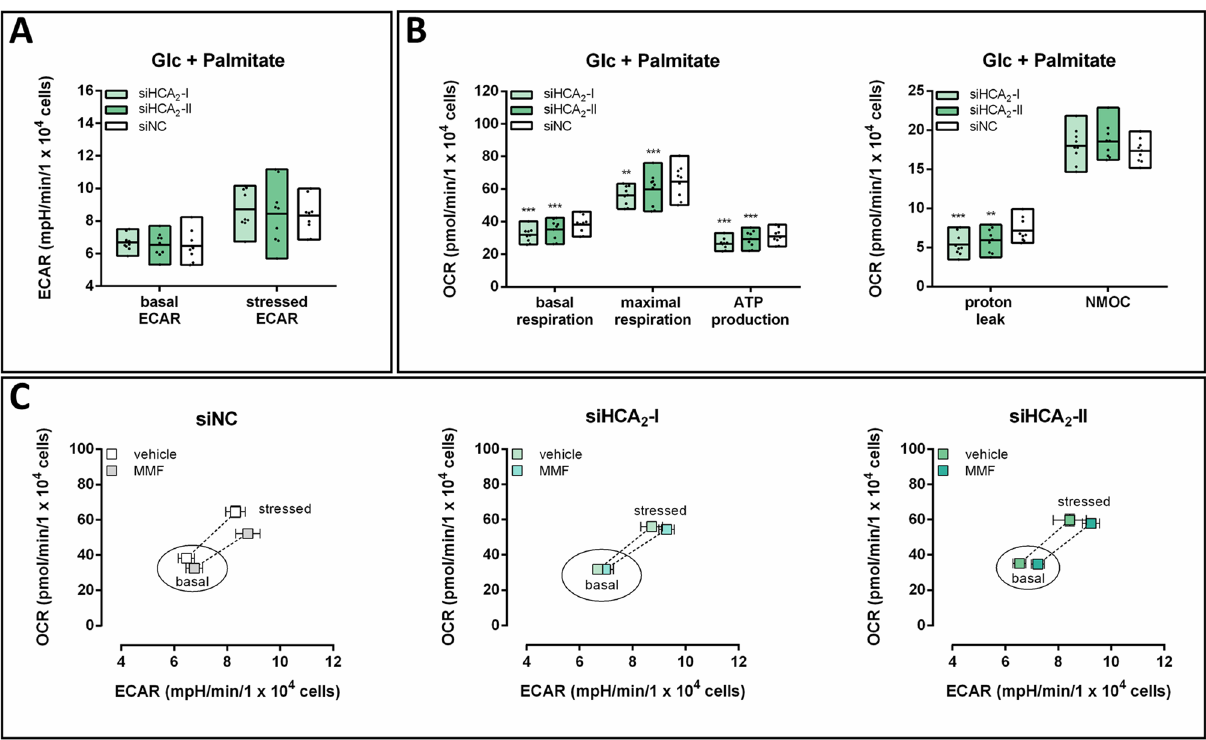
Fig. 3 Mitochondrial respiration was reduced in cells with knockdown of HCA BT-474 cells were transfected with siNC or two different siRNAs targeting HCA presence of glucose and palmitate (Glc + palmitate). Knockdown of HCA respiration. C The metabolic phenotype and potential (dotted line) of BT-474 cells were determined in the absence and presence of the HCA agonist monomethyl fumarate (MMF). Stimulation with MMF caused an HCA 2 stressed conditions. Data are shown as floating bars (min to max; A , B ) or mean ± SEM ( C ) of three time points of three independent experi- ments, each carried out in six technical replicates. Statistical analyses were performed using repeated measures one-way ANOVA. **P ≤ 0.01; *** P ≤